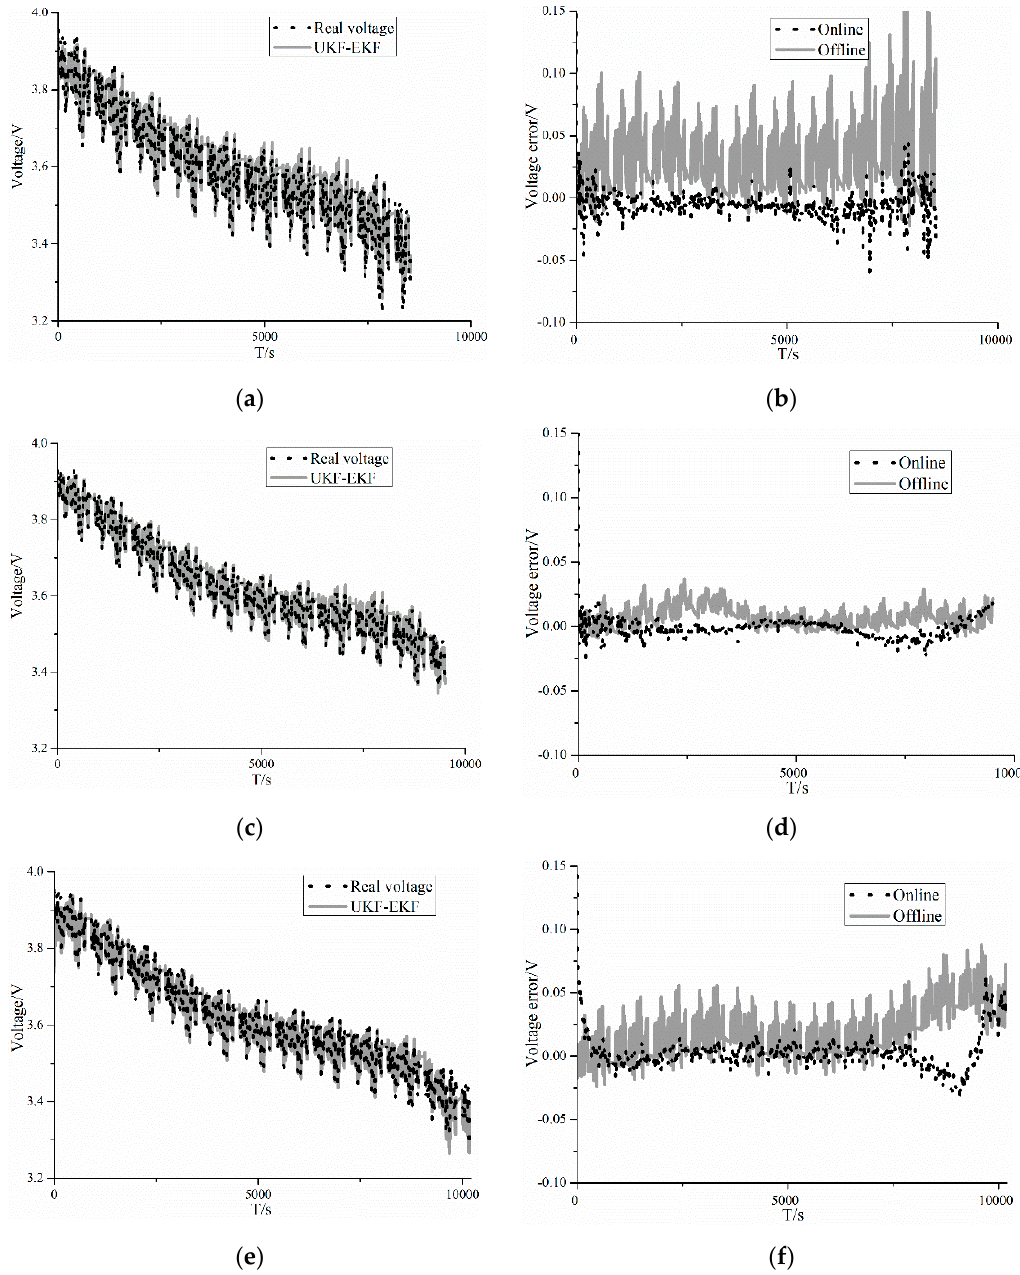
Figure 7. Results of voltage comparisons in BJDST: ( a ) comparison between the UKF–EKF model voltage and real voltage at 0 °C; ( b ) comparison of voltage errors between online and offline estimations at 0 °C; ( c ) comparison between the UKF–EKF model voltage and real voltage at 25 °C; ( d ) comparison of voltage errors between online and offline estimations at 25 °C; ( e ) comparison between the UKF–EKF model voltage and real voltage at 45 °C; ( f ) comparison of voltage errors between online and offline estimations at 45 °C.